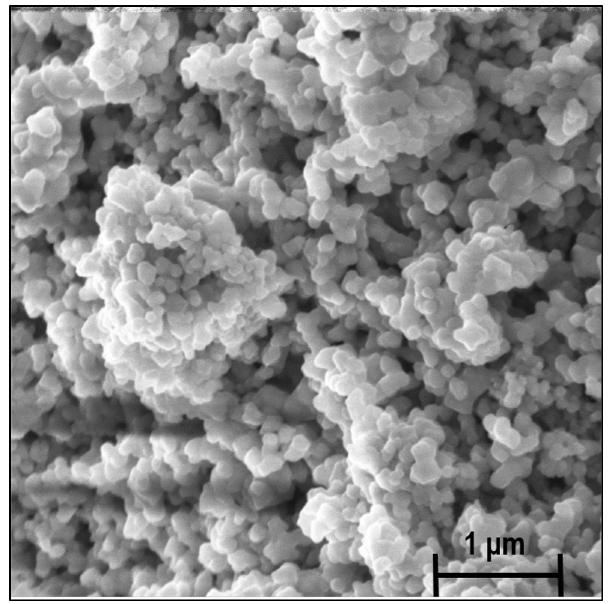
Figure 2. Typical SEM image of the LN samples prepared by the solvothermal synthesis by using pre-milled Nb 2 O 5 as solid reactant.